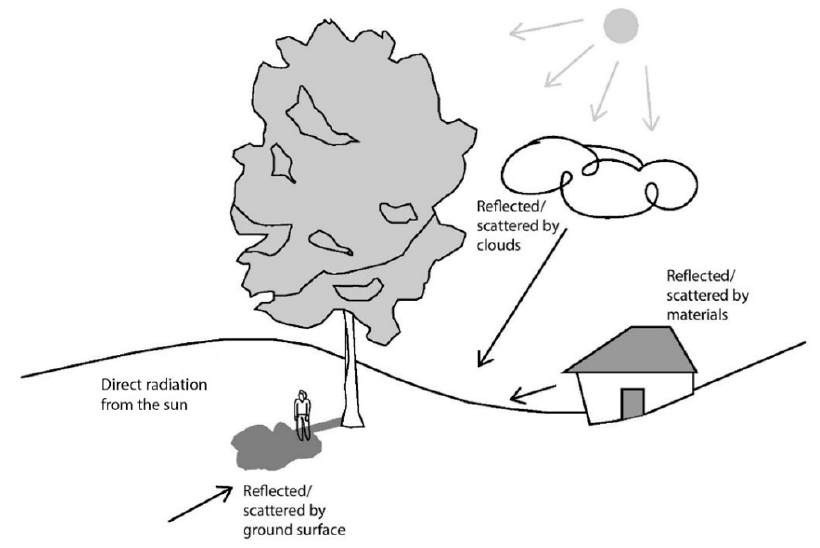
Figure 2. Incidence of indirect UVR